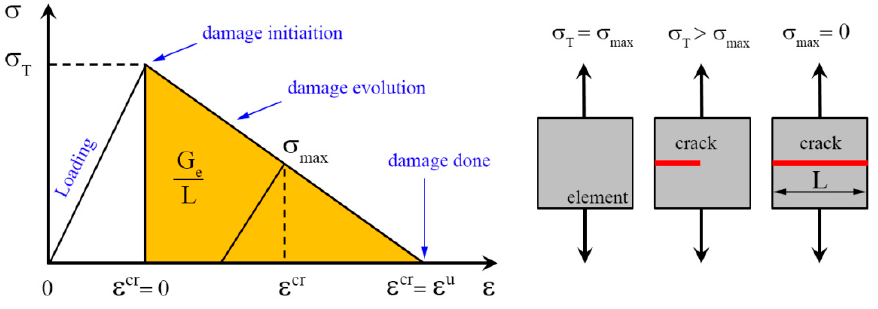
Figure 9. Schematic of softening damage criterion.